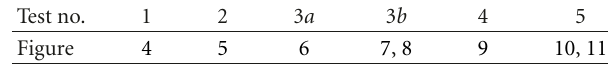
Table 10: Tests results